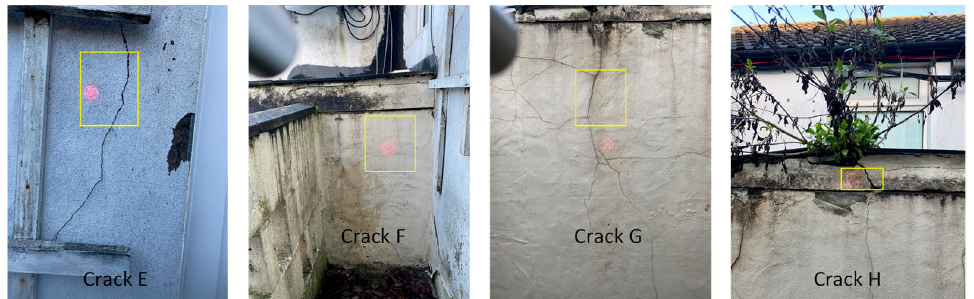
Figure 7. Application of the laser method in outdoor scenarios.